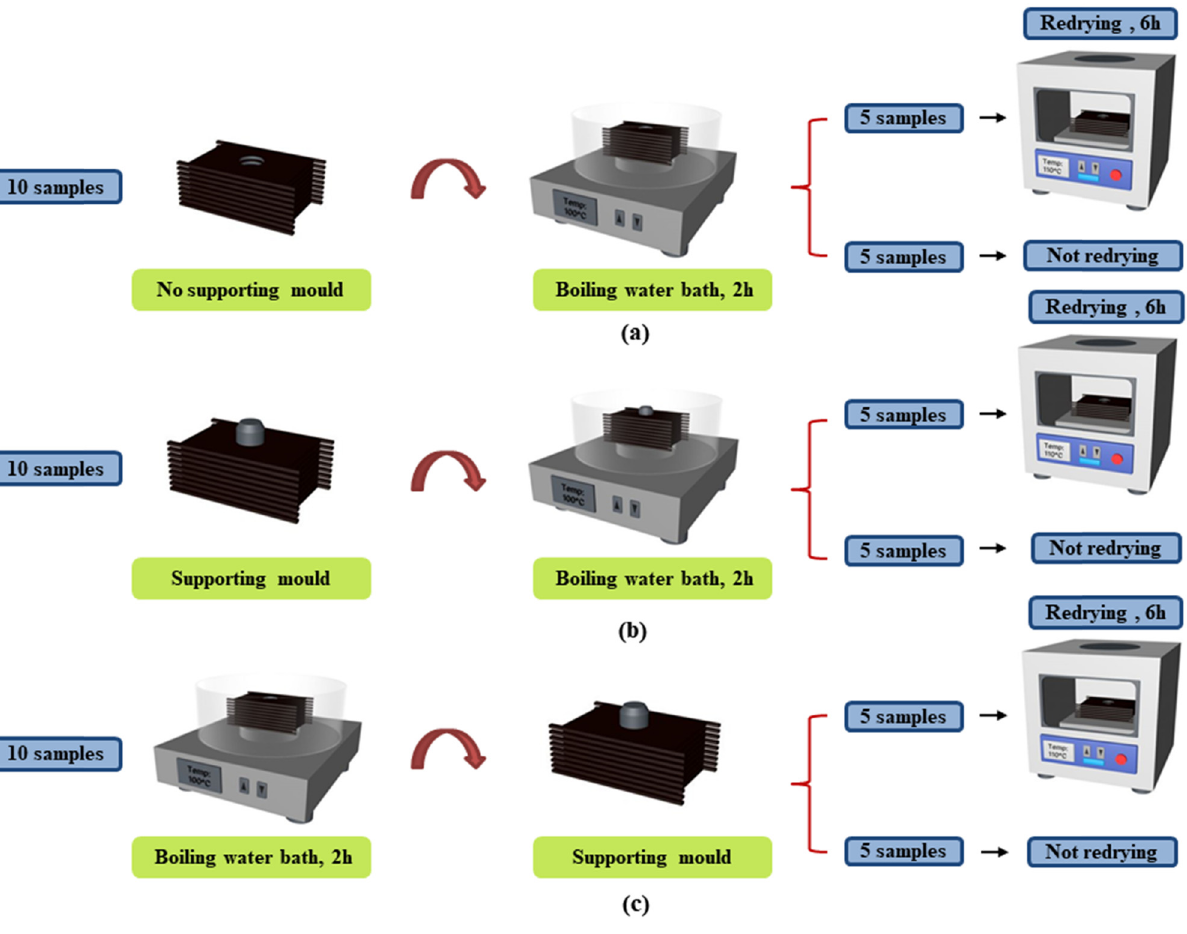
Figure 4: The three routes after injection molding: ( a ) I, ( b ) II, and ( c ) III.